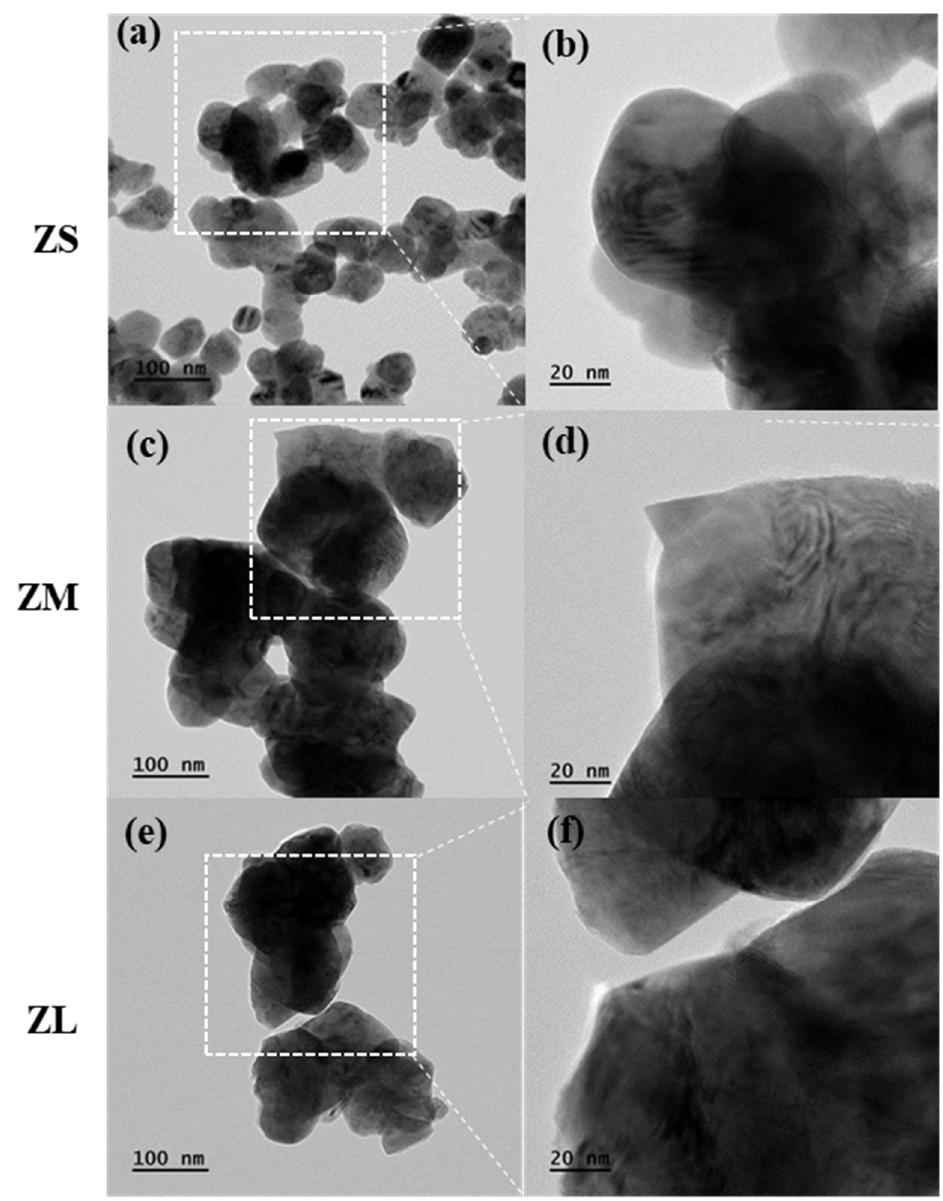
Figure 5. TEM images of control groups (ZS, ZM, ZL): ( a ) ZS ×100K, ( b ) ZS ×200K, ( c ) ZM ×100K, ( d ) ZM ×200K, ( e ) ZL ×100K, and ( f ) ZL ×200K.